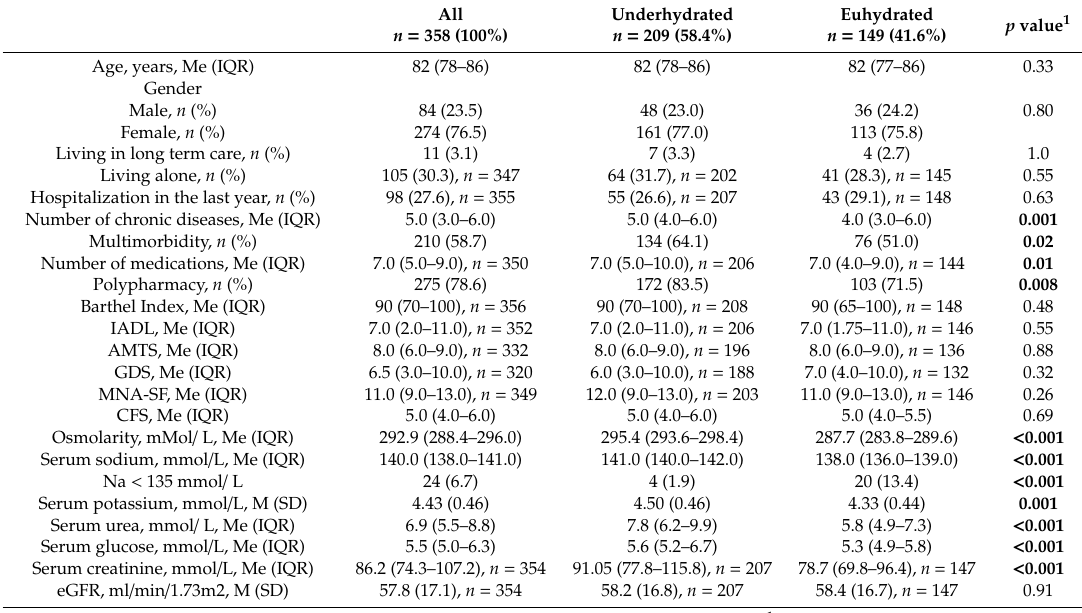
Table 1. Descriptive characteristics of participants at admission, stratified by hydration status. All n = 358